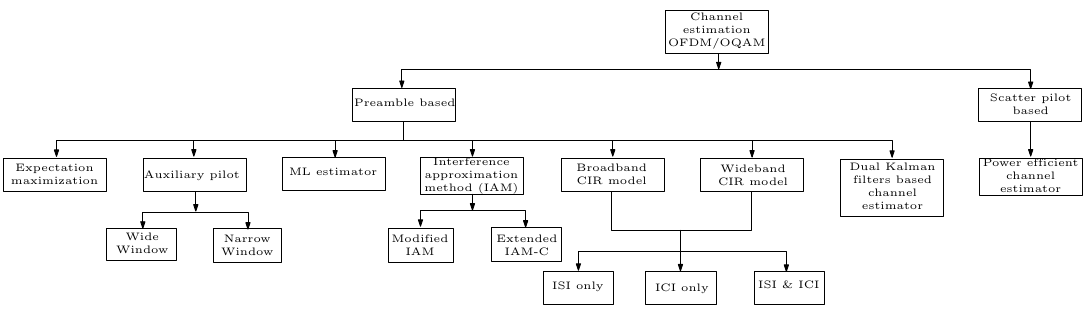
Figure 13. CE schemes for filter bank